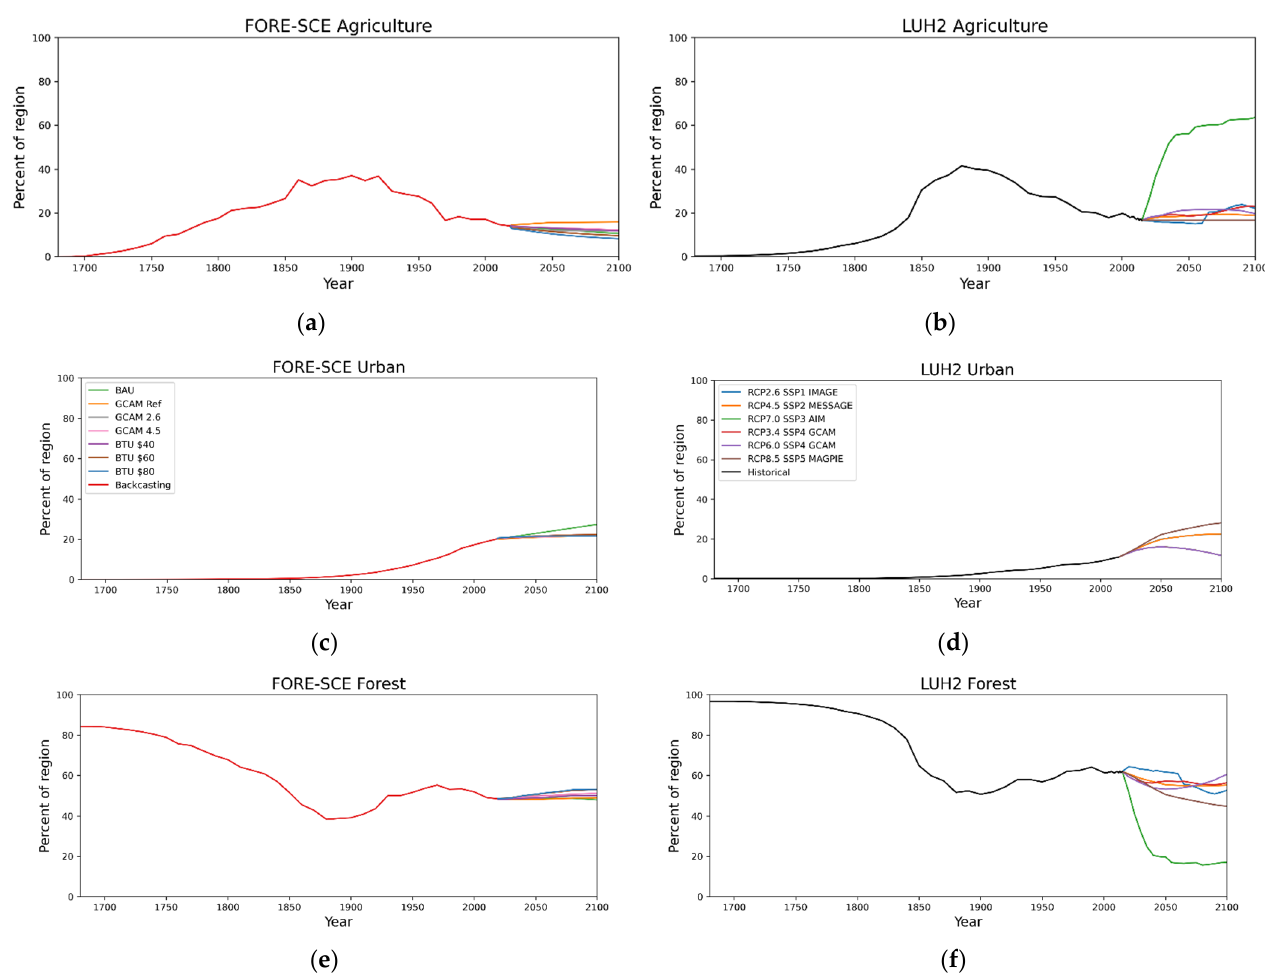
Figure 11. Comparison of FORE-SCE and LUH2 modeled LULC from 1680–2100 in the DRB for major categories ( a , b ) Agriculture; ( c , d ) Urban; and ( e , f ) Forest.